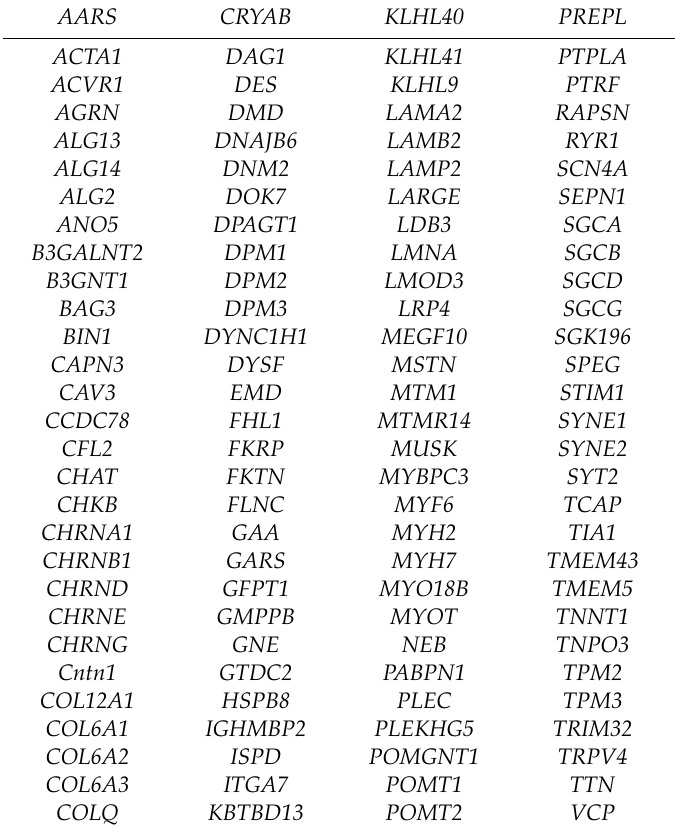
Table 1. Genes included in the custom targeted next-generation sequencing